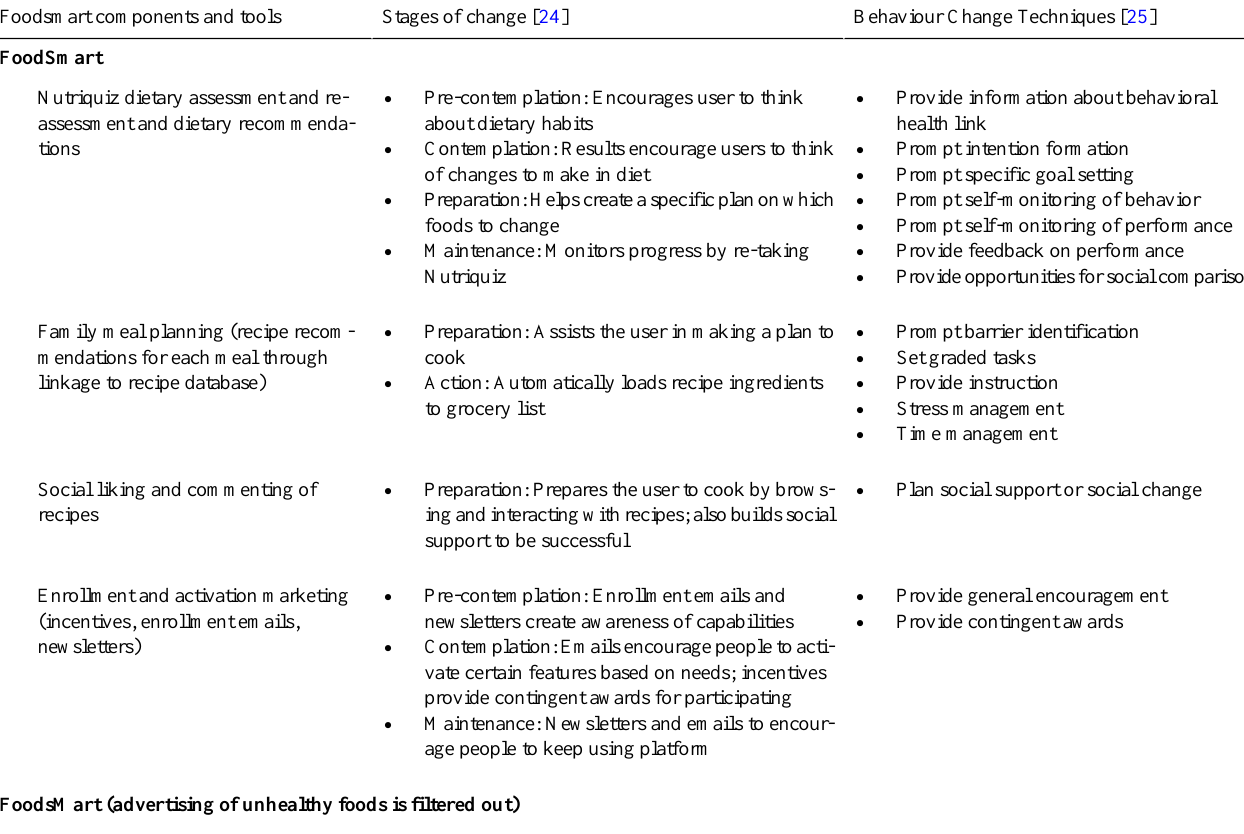
Table 1. Foodsmart platform components and tools linked with behavior change stages and